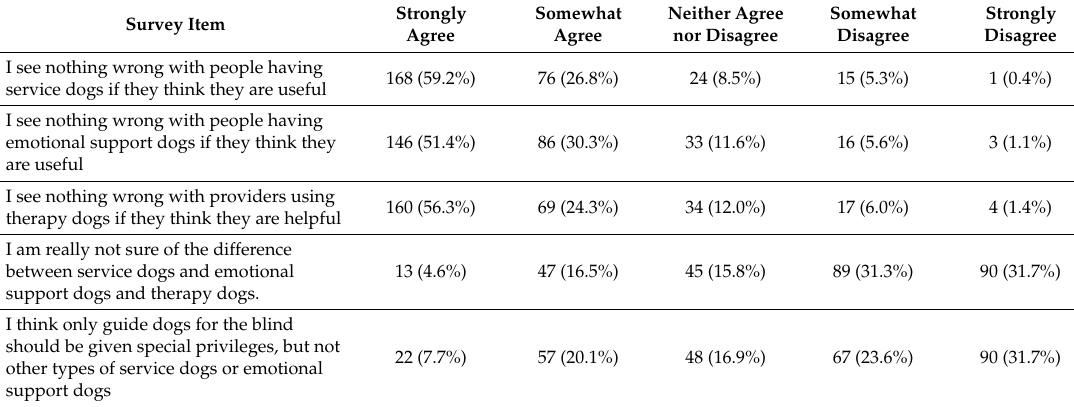
Table 3. Attitudes towards assistance